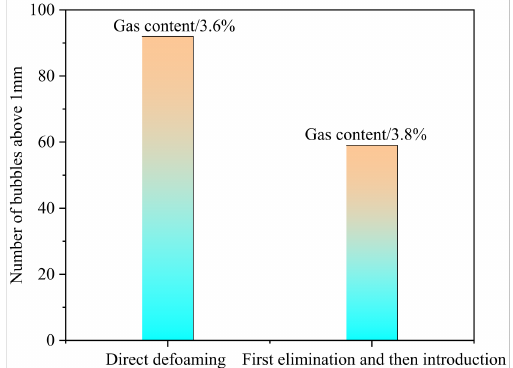
Figure 20. Air void control method: number of bubbles above 1 mm.